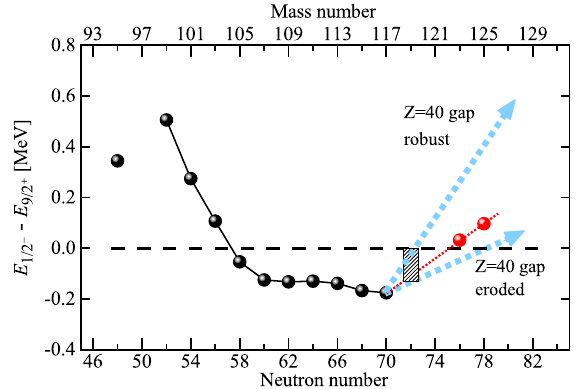
Figure 2. Systematics of experimental energy di ff erences be- tween the lowest-lying 1 / 2 − and 9 / 2 + states in odd- A Ag isotopic chain [15]. Copyright (2019), with permission from the Ameri- can Physical Society.